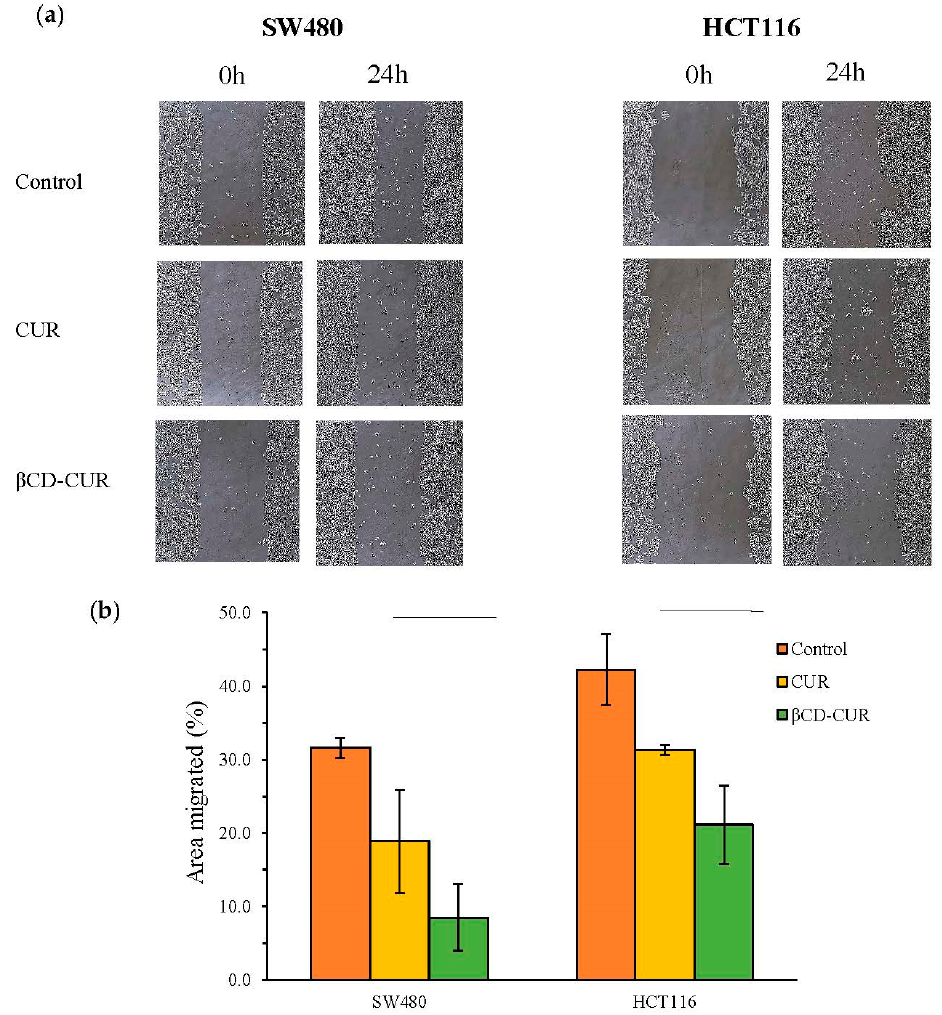
Figure 5. The effect of CUR and β CD-CUR inclusion complex on the migration properties of CRC cell lines. ( a ) The wound healing assays for SW480 and HCT116 cells. ( b ) The bar chart represents the measurement of the distance between the boundaries of the migrating cells 24 h after the treatment. The area migrated between CUR and β CD-CUR groups was reported as mean ± S.D. from three replicates.